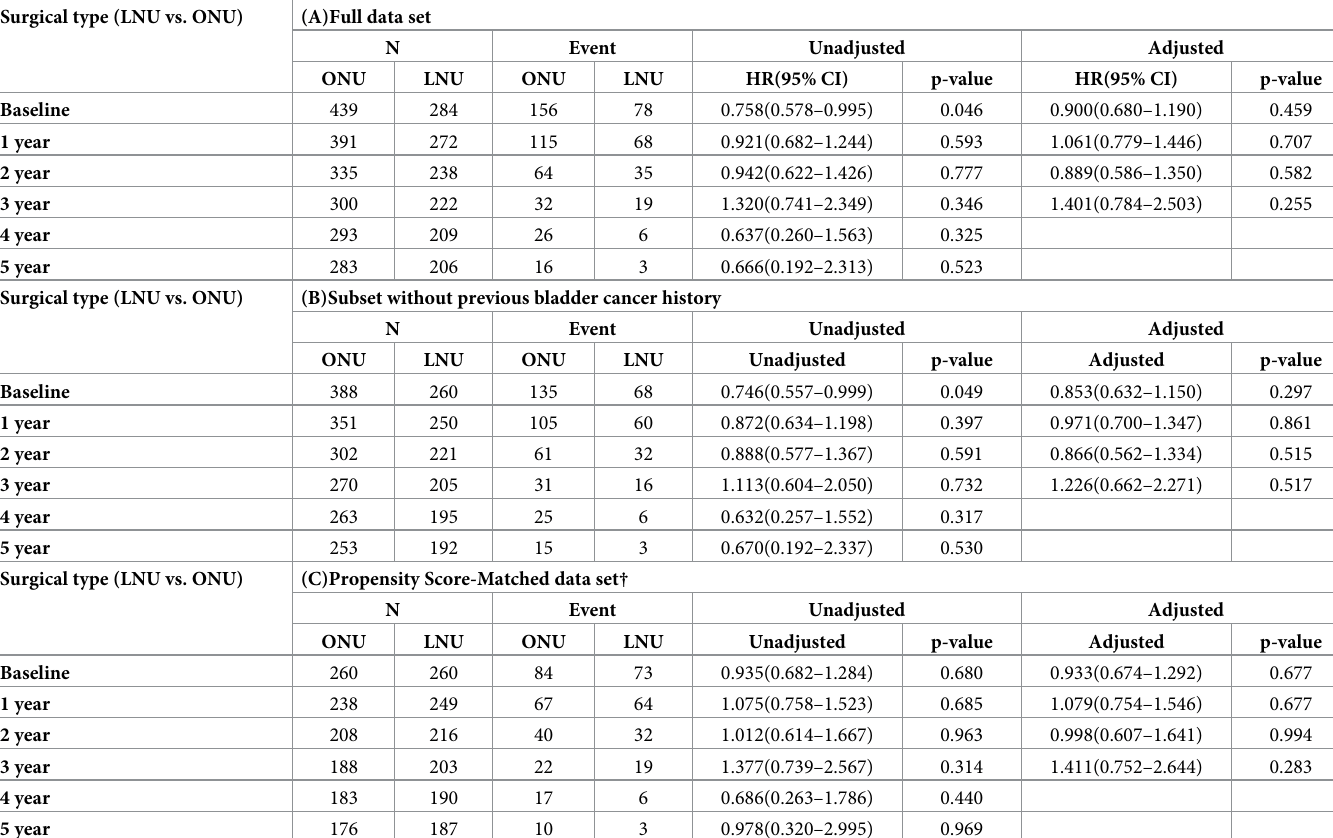
Table 3. Comparison of conditional cancer-specific survival between open and laparoscopy procedures during 5-year follow-up after radical nephroureterectomy (A) among all patients (N = 723), (B) patients without previous history of bladder cancer only (N = 648), and (C) after propensity-score matching. Surgical type (LNU vs. ONU)